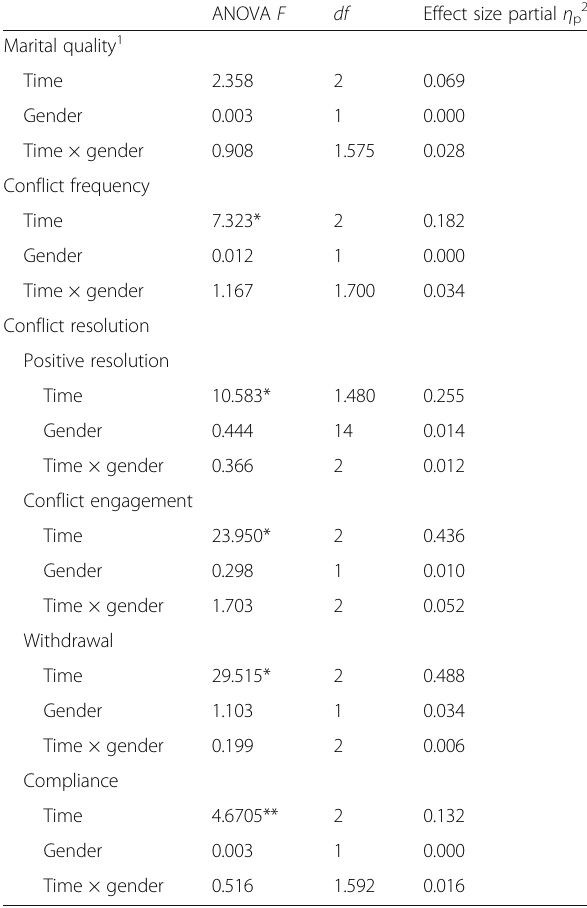
Table 5 Repeated measures ANOVAs for husbands ’ and wives ’ dyads at the three times ANOVA F df Effect size partial η